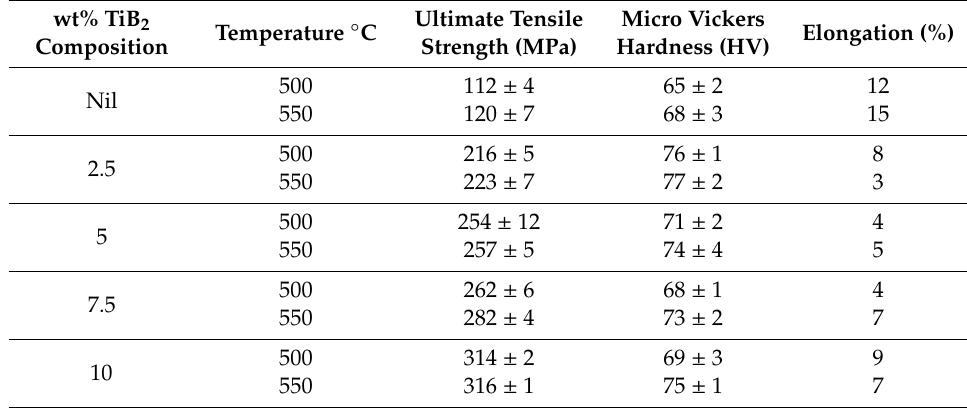
Table 3. Mechanical properties of the aluminum alloy.